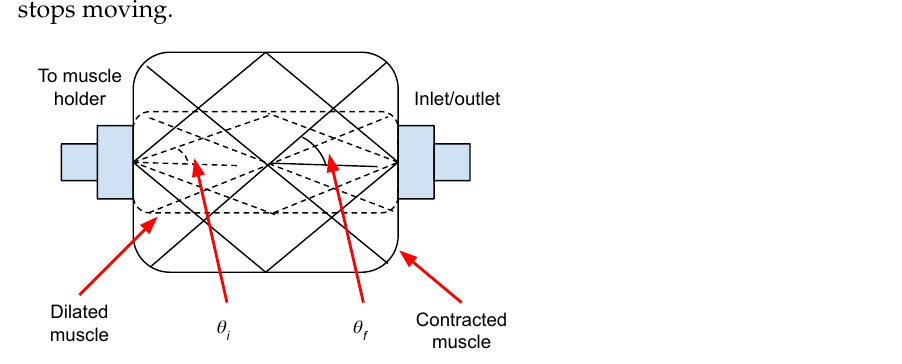
Figure 5. Comparison of braid angle before and after contraction. Initial braid angle, θ i , is smaller than final braid angle, θ f .